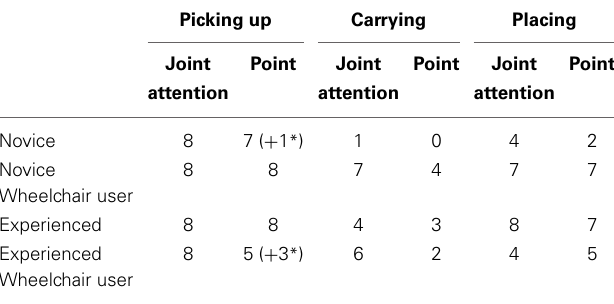
Table 1 | Number of dyads where joint attention and/or